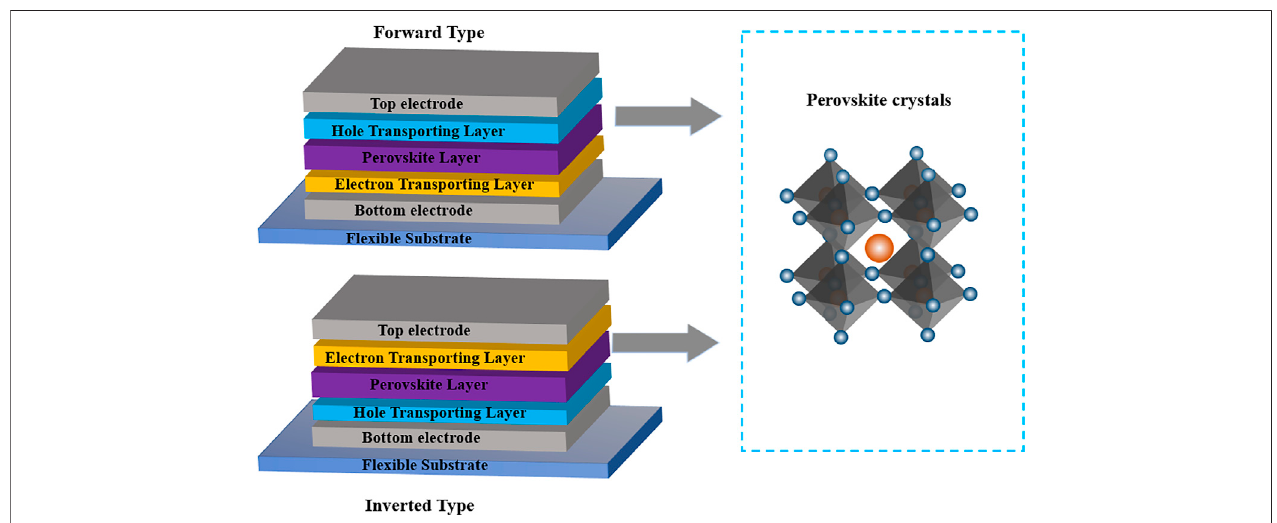
FIGURE 1 | Two general device structures of perovskite solar